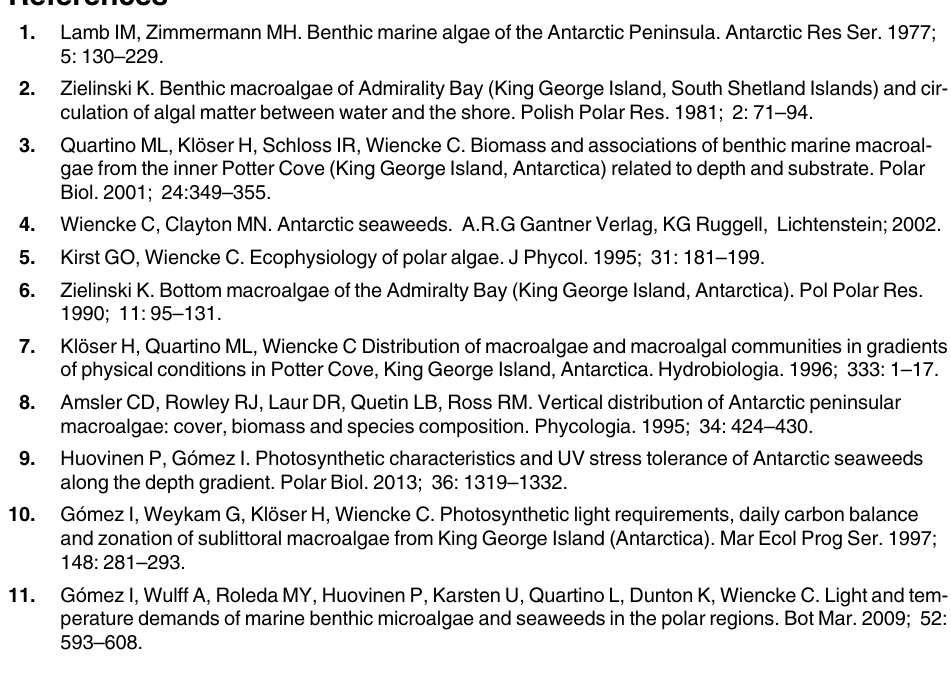
S1 Table. Summary of one-way ANOVA results for the differences in photosynthetic char- acteristics estimated from P-I curves (Table A); soluble and insoluble phlorotannin con- tents (Table B) and antioxidant capacity (Table C) measured in four Antarctic brown algae collected at three depths each. Significances: (cid:4) = p < 0.05; (cid:4)(cid:4) = p < 0.01; (cid:4)(cid:4)(cid:4) = p > 0.001. S2 Table. Summary of two-way ANOVA results for the effect of depth and UV treatment /F ) (Table A); contents of soluble phlorotannins on the maximal quantum yield (F v m (Table B) and antioxidant activity (Table C) measured in four Antarctic brown algae col- lected to three depths each. Significances: (cid:4) = p < 0.05; (cid:4)(cid:4) = p < 0.01; (cid:4)(cid:4)(cid:4) = p > 0.001.